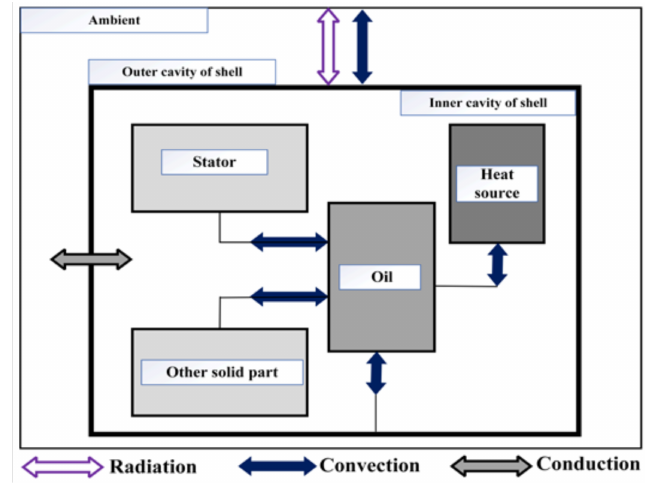
Figure 2. Schematic of oil heat transfer in the sealed